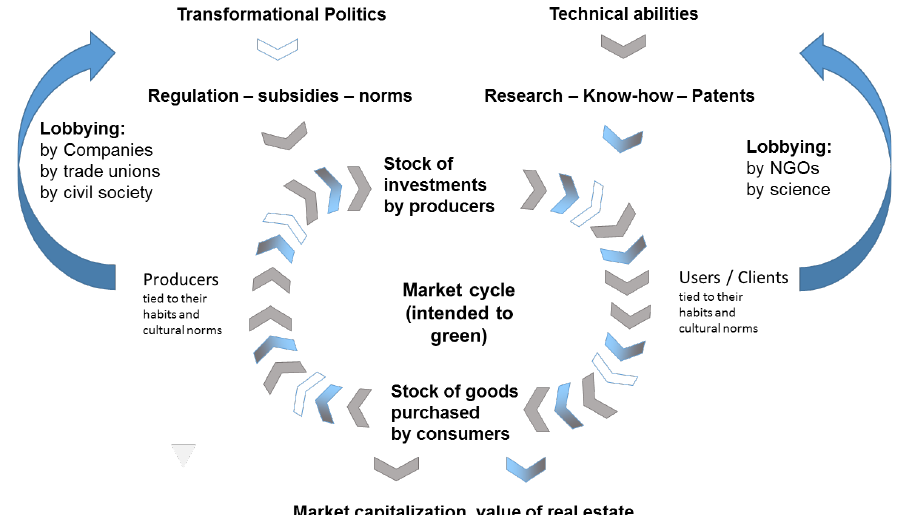
Fig. 5. Interdependencies of path dependencies. Source: Borderstep Institute At the center of the transformation-dynamics there are a huge number of markets in which goods are sold and bought. Many of the goods or technologies are part of larger technological systems and regimes (Kemp, 1994) and the transformation of such markets is heavily interrelated. These goods or technological systems may or may not be sustainable, and suppliers as well as users are locked in habits, organizational structures, or simply in investments and infrastructures which make it easy to follow the old